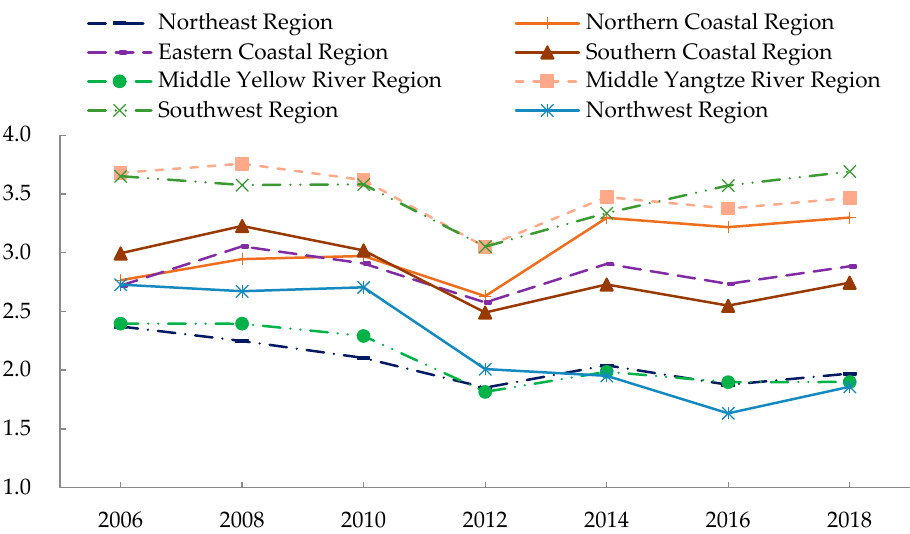
Figure 2. Temporal evolutionary trends of EWP in eight economic regions.